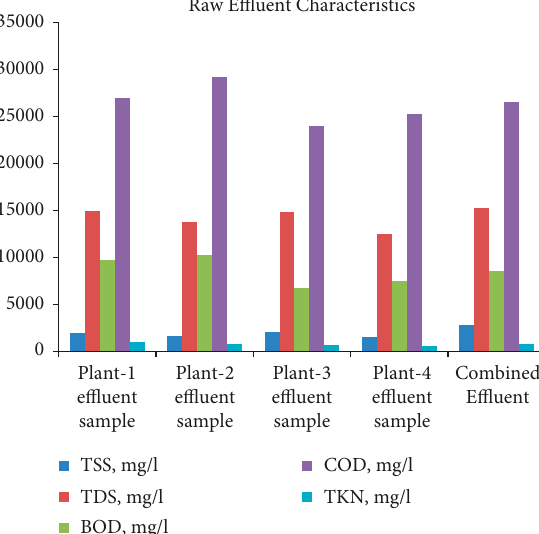
Figure 5: Characteristics of raw pharmaceutical effluent.